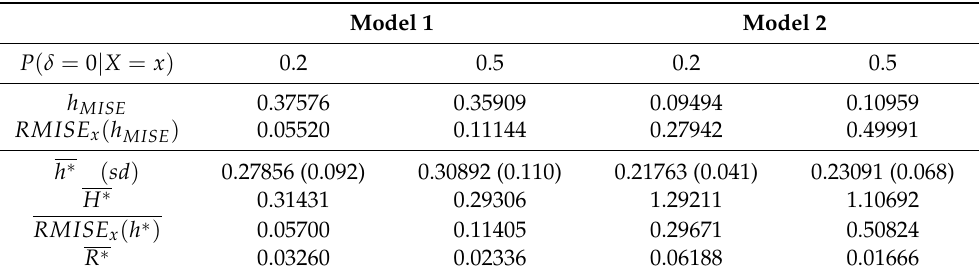
Table 1. MISE, average bootstrap bandwidths and estimation errors of Beran’s PD estimator in each level of censoring conditional probability for Models 1 and 2. Numbers within brackets are standard